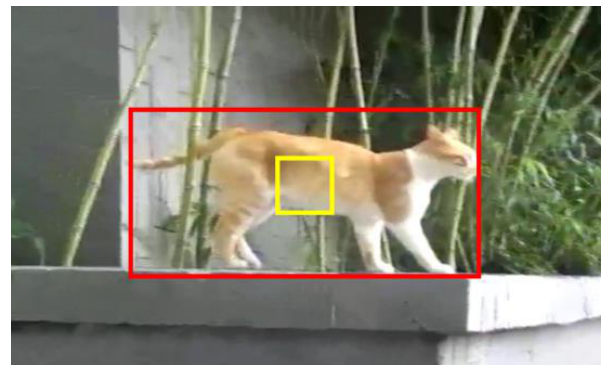
Figure 2. Schematic diagram of the selected positive samples. The red part is the originally defined positive sample area, and the yellow part is our improved positive sample area. The regression branch of the network produces a regression feature map A reg , which has dimensions of 25 × 25 × 4. Each position ( i , j ) in A reg can be mapped back to the corresponding location in the search area ( x , y ). The regression objective of A reg at ( i , j ) is a four-dimensional vector t ( = ( l , t , r , b ), which can be calculated as: i , j )